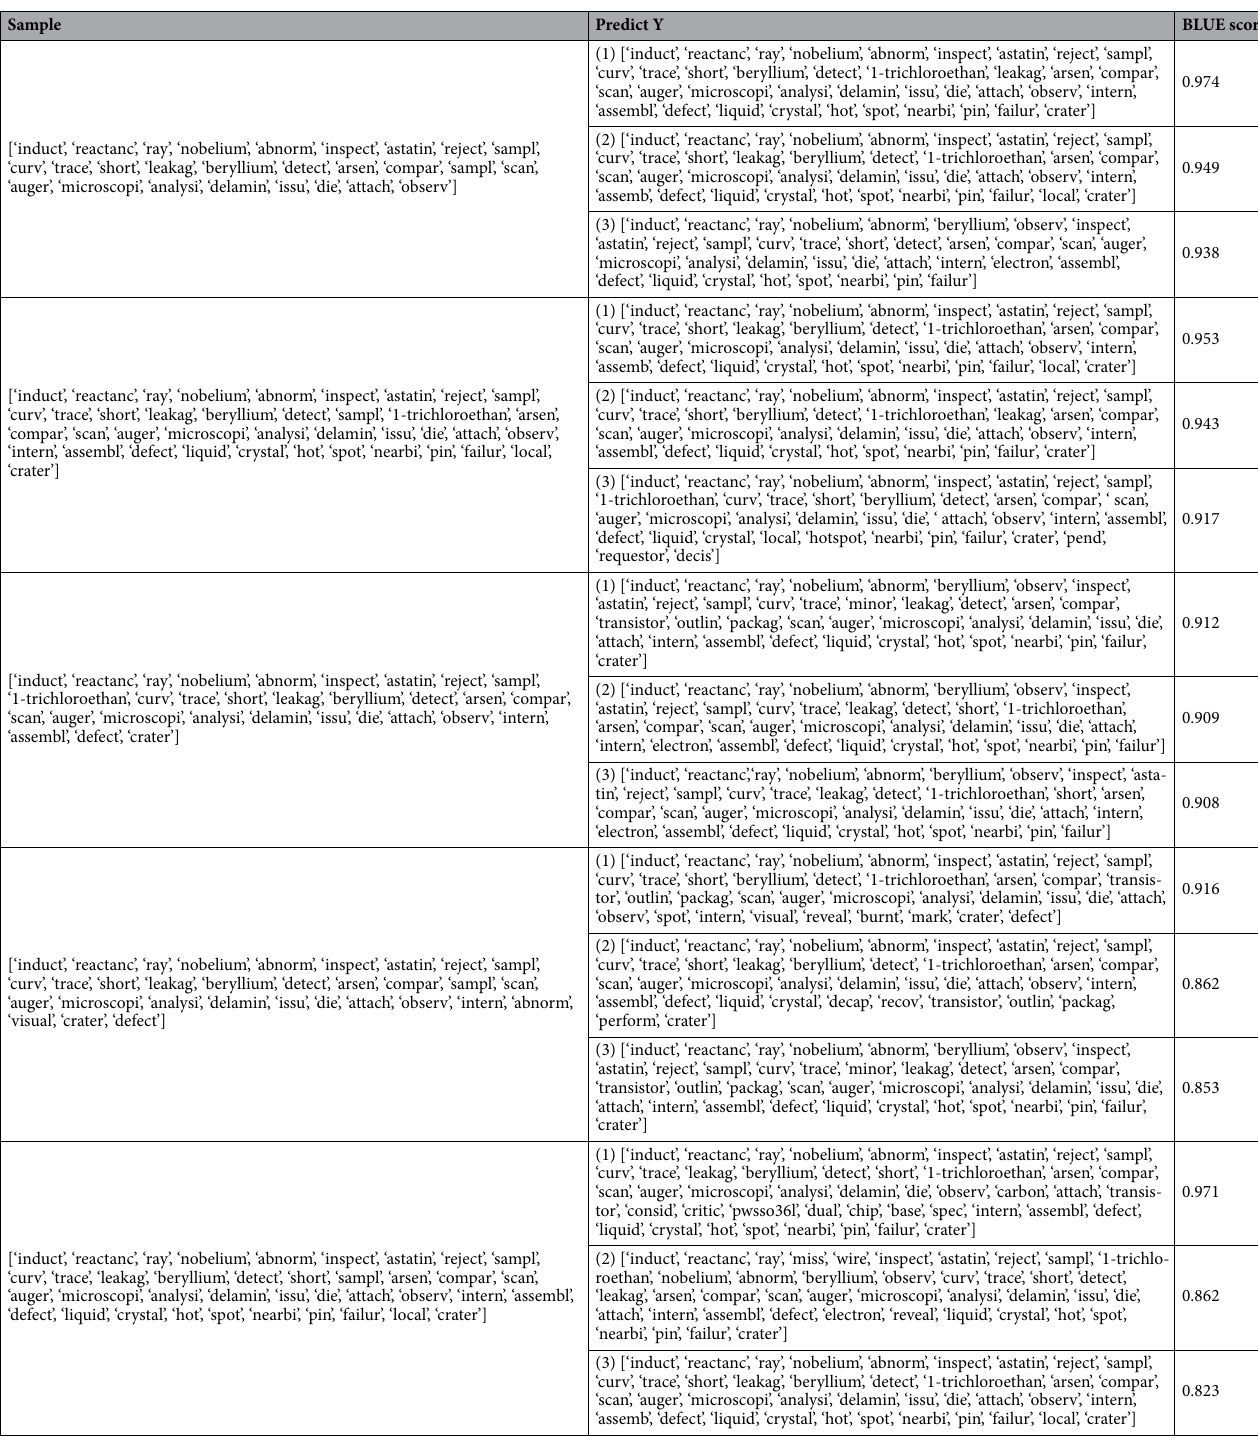
Table 4. Some examples of textual samples of analysis conclusion and their three best predictions by the GA-DT